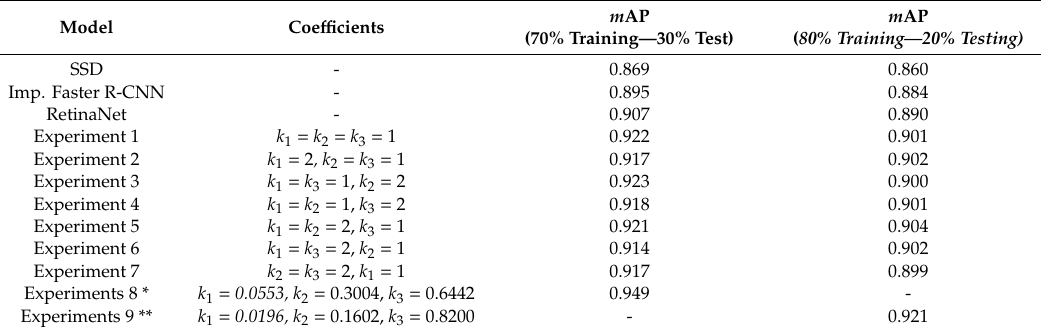
Table 2. Comparison of the results of three di ff erent object detection models and di ff erent coe ffi cient combinations for the Remote Sensing Object Detection (RSOD) dataset.